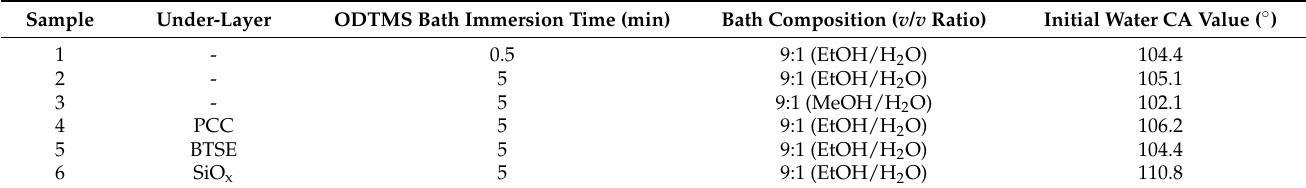
Table 1. Samples and details of their